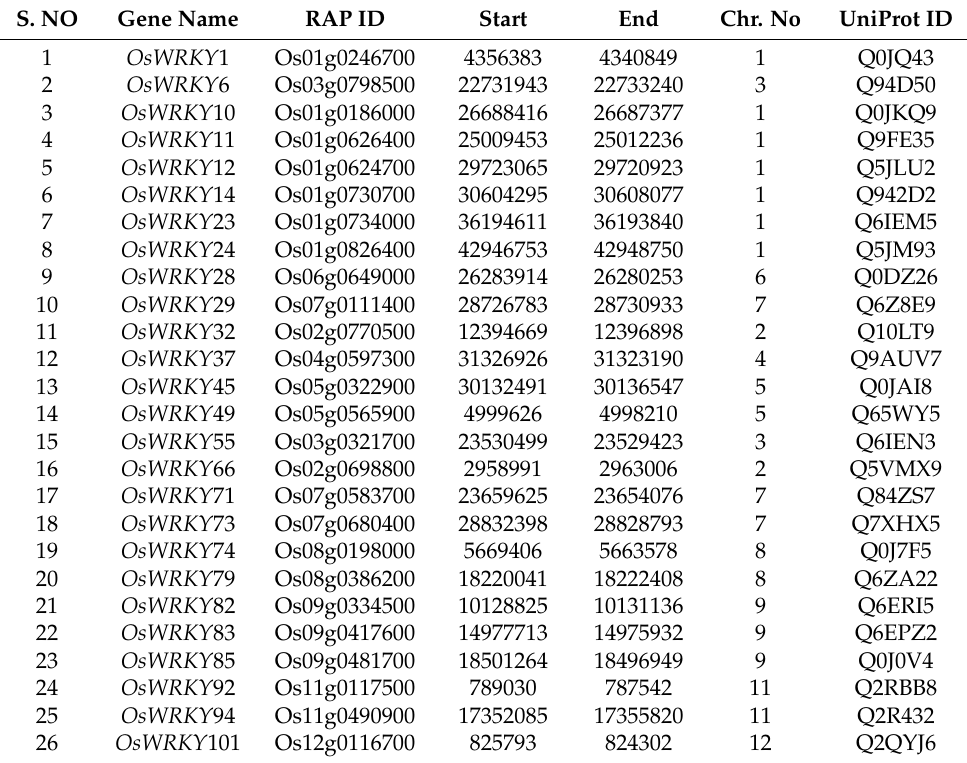
Table 1. OsWRKY TF family members and their